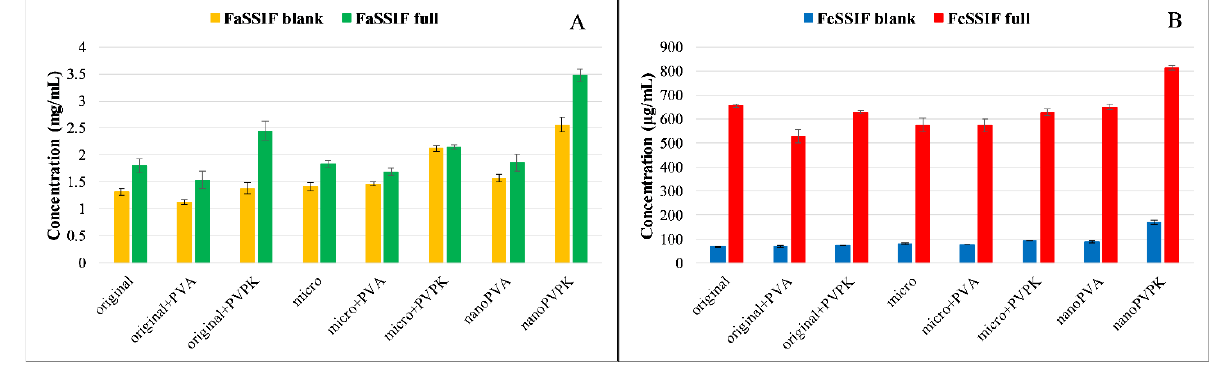
Figure 7. Solubility of niflumic acid in FaSSIF blank/full ( A ) and FeSSIF blank/full ( B ) buffers.